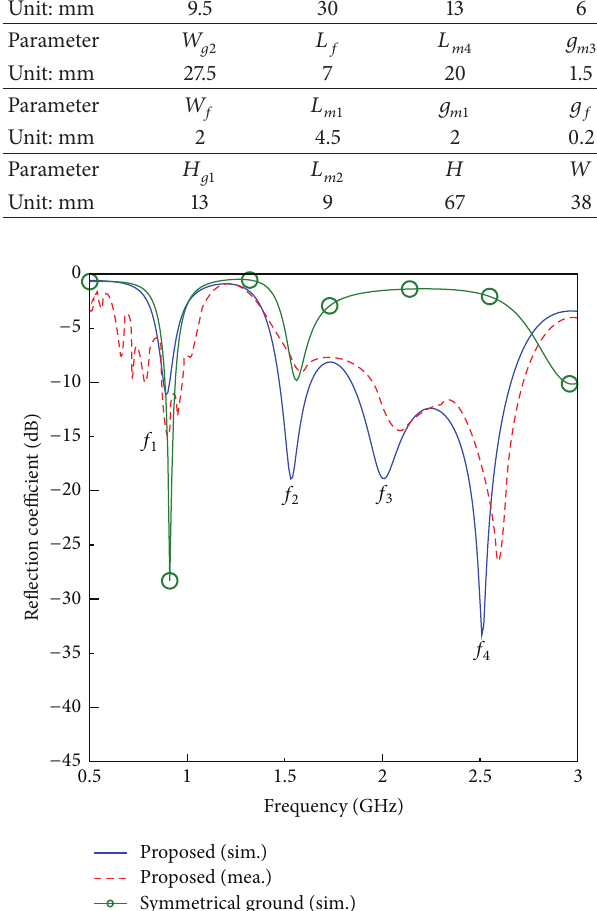
Figure 2: Simulated and measured reflection coefficients of the proposed